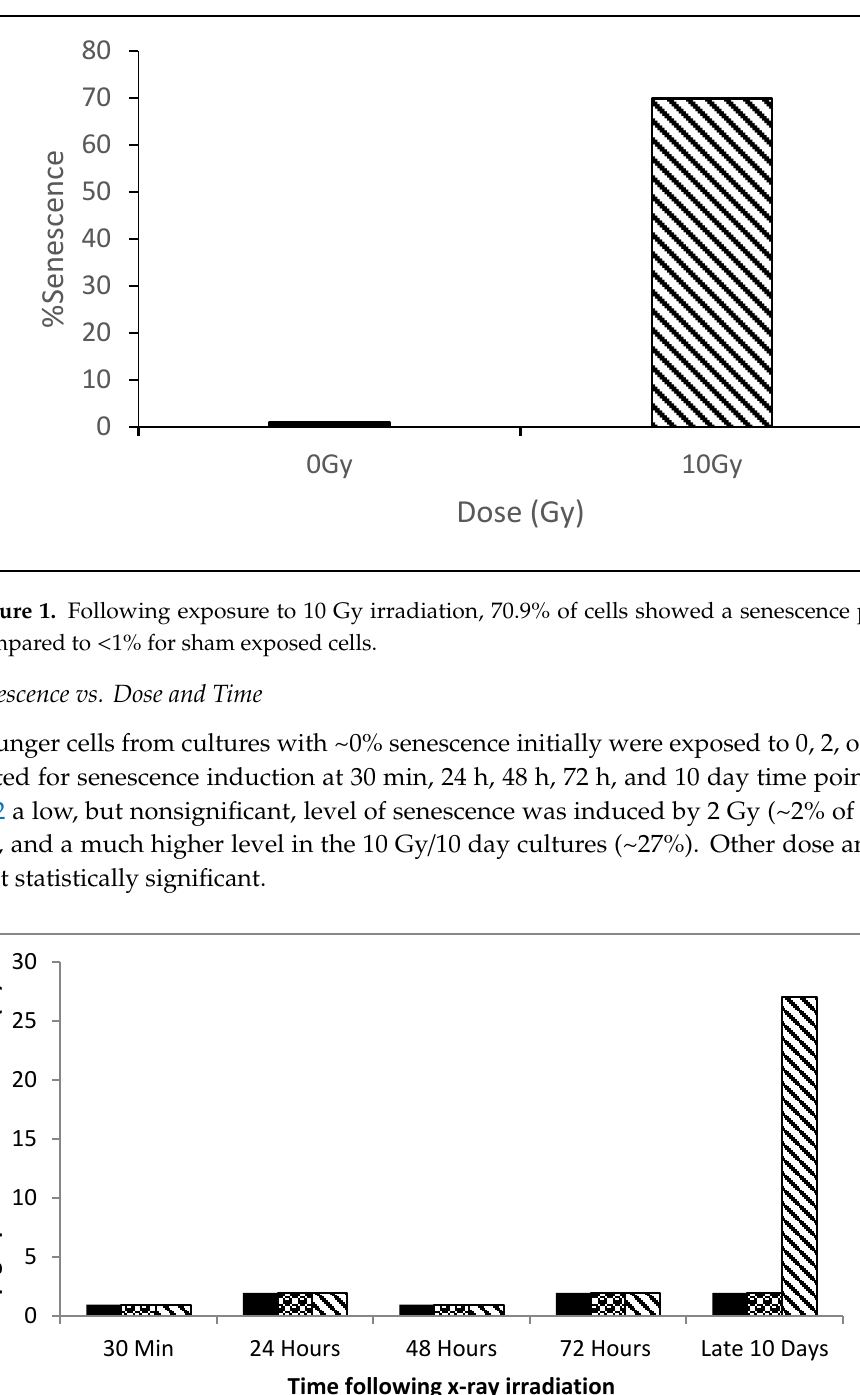
Figure 1. Following exposure to 10 Gy irradiation, 70.9% of cells showed a senescence phenotype compared to <1% for sham exposed cells.